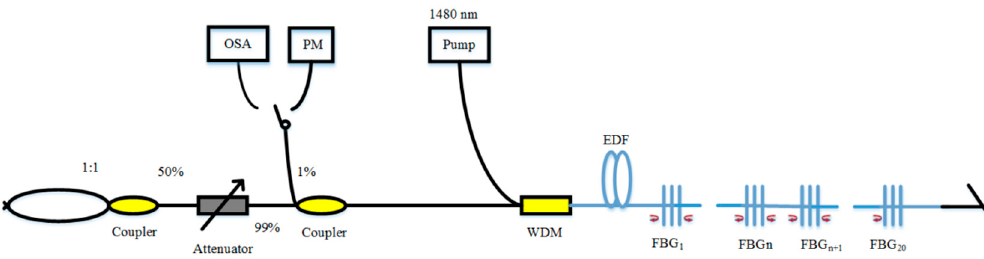
Figure 4. Schematic diagram of the experimental setup of the RFL based on erbium-doped fiber (EDF). OSA, optical spectrum analyzer; PM, power meter.